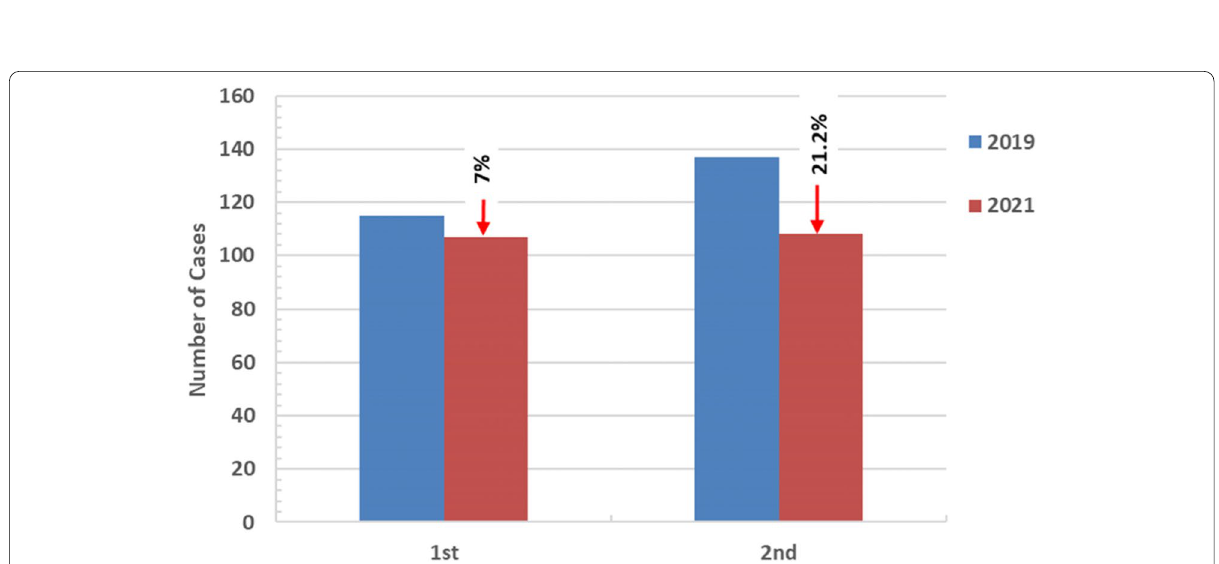
Fig. 5 Percent changes in number of TB cases in first two quarters (2021 vs. 2019) in Assiut Chest Hospital, Egypt. (